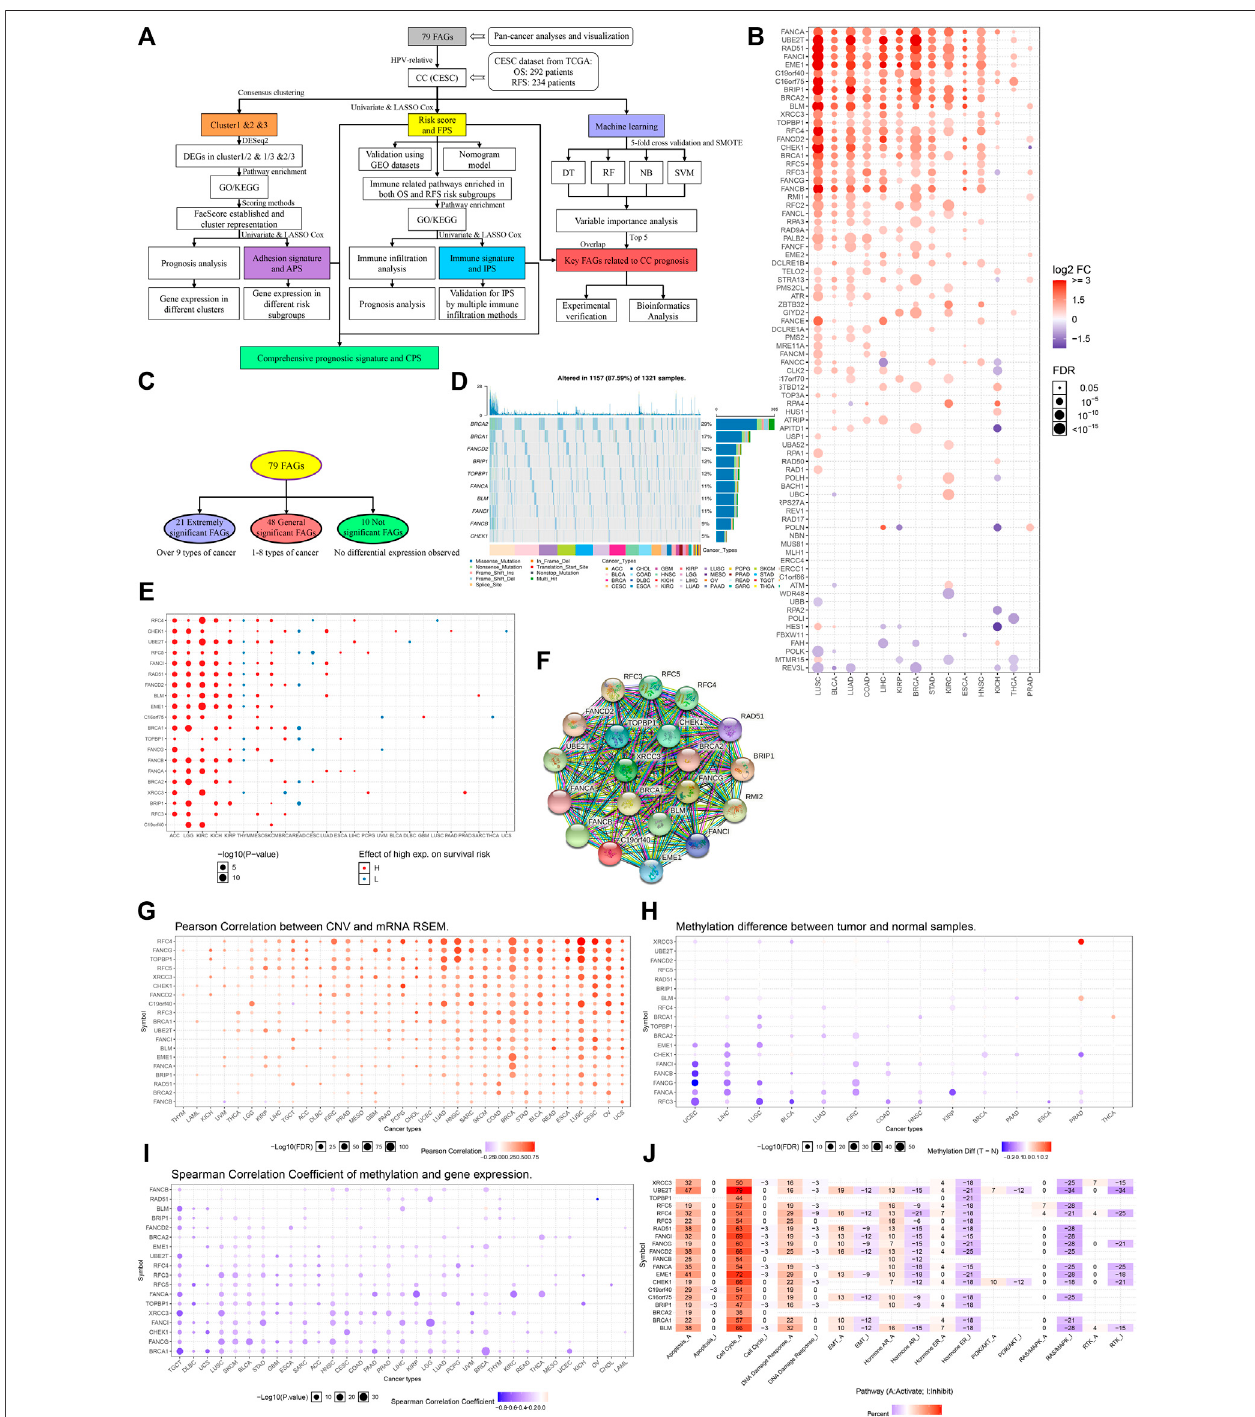
FIGURE1| Pan-canceranalysesofFARGsamongtumors. (A) The fl owchartofthewholestudy.FARGs,Fanconianemiarelatedgenes;CESC,cervicalsquamous cell carcinoma and endocervical adenocarcinoma; DEGs, differentially expressed genes; GO, gene ontology; KEGG, Kyoto Encyclopedia of Genes and Genomes; OS, overall survival; RFS, recurrence-free survival; LASSO, least absolute shrinkage and selection operator algorithm; TCGA, The Cancer Genome Atlas; GEO, gene expression omnibus; SMOTE, the synthetic minority over-sampling technique; DT, decision tree; RF, random forest; NB, naïve bayes; SVM, support vector machines. (B) Different RNA expression patterns of FARGs between tumor and normal tissues among 14 cancers. ACC, adrenocortical carcinoma; BLCA, bladder urothelial carcinoma; BRCA, breast invasive carcinoma; CESC, cervical squamous cell carcinoma and endocervical adenocarcinoma; CHOL, cholangiocarcinoma;